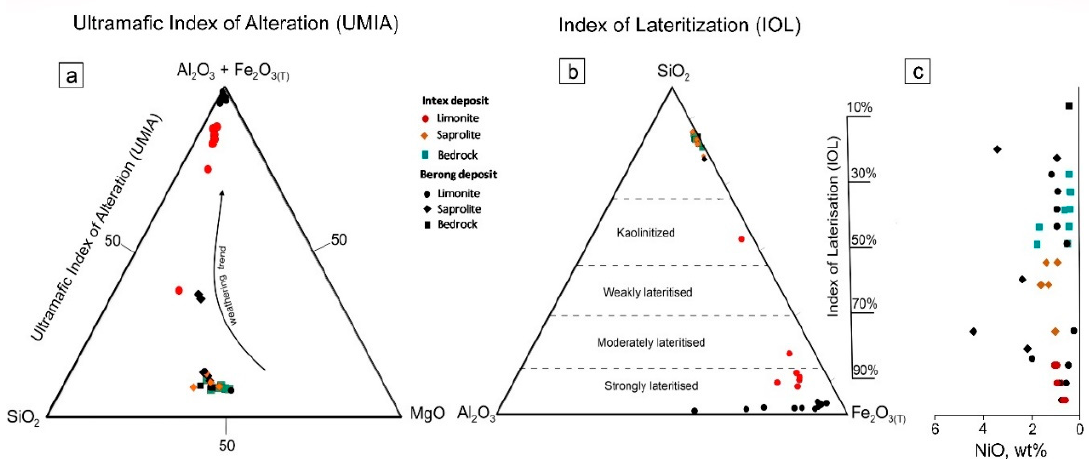
Figure 19 . Molar ternary plot of ( a ) Al 2 O 3 +Fe 2 O 3 +-SiO 2 -MgO showing the weathering of ultramafic bedrock from Intex deposit with the depletion of SiO 2 and MgO and relative enrichment of Al 2 O 3 and Fe 2 O 3 . ( b ) Mass ternary plot of SiO 2 -Al 2 O 3 -Fe 2 O 3 displaying the Index of Lateritization (IOL) for Intex deposit as well as the Berong deposit in Palawan, Philippines. ( c ) Bulk Ni contents in the bedrock and weathered horizons of the Intex and Berong deposits.